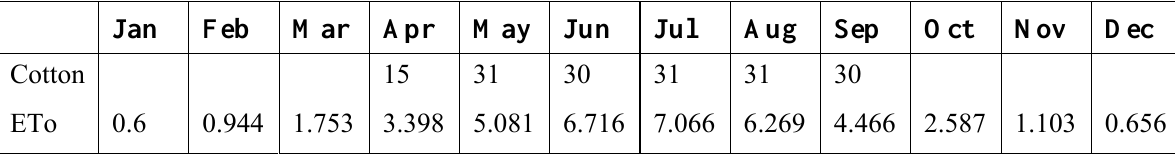
Table 5. Monthly ETo (mm/day) and number of days in each month for cotton